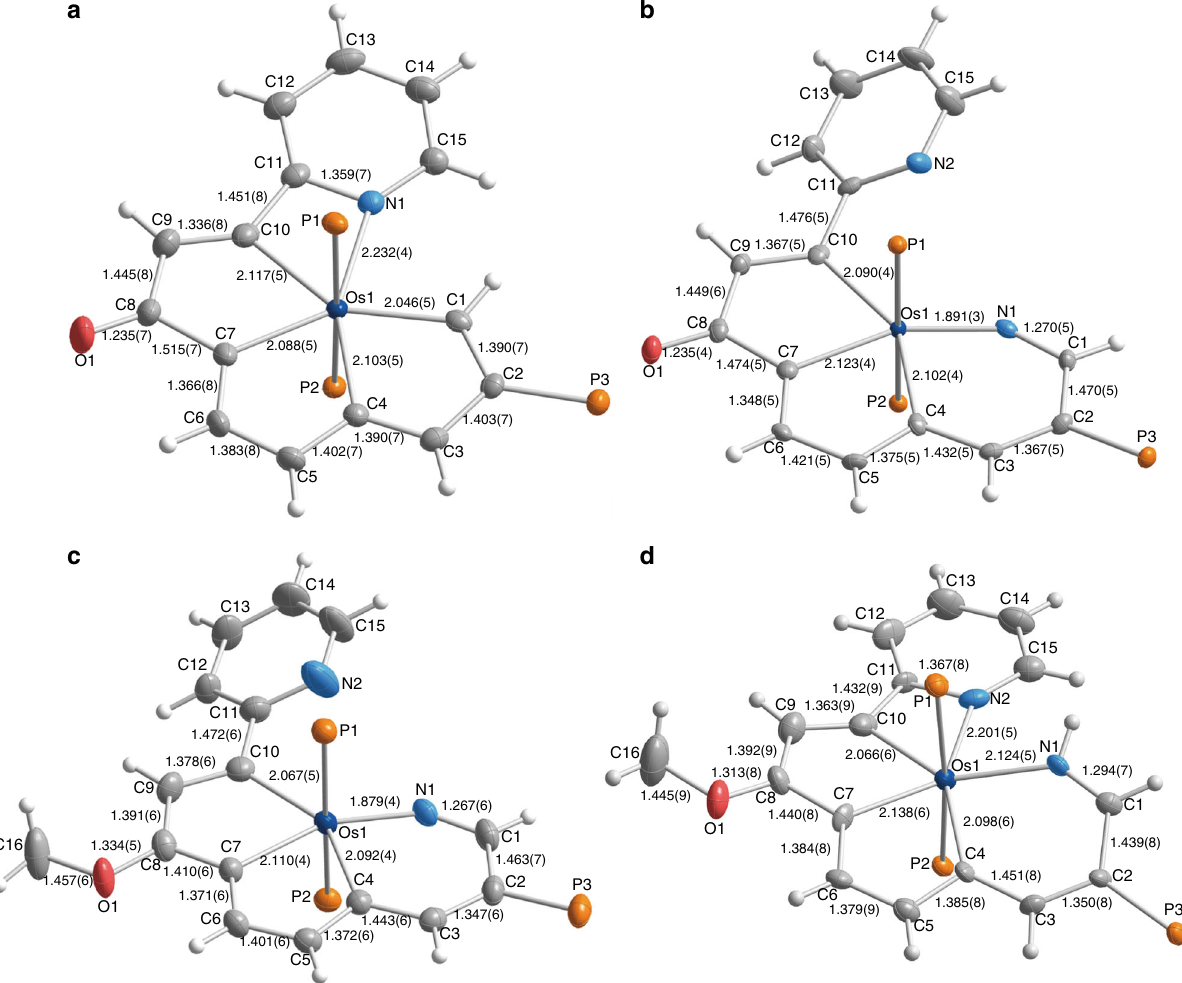
Fig. 3 X-ray structures of the cationic parts of 2 ( a ), 3 ( b ), 4 ( c ), and 5 ( d ). Thermal ellipsoids are set at the 50% probability level. The phenyl groups in the PPh 3 moieties are omitted for